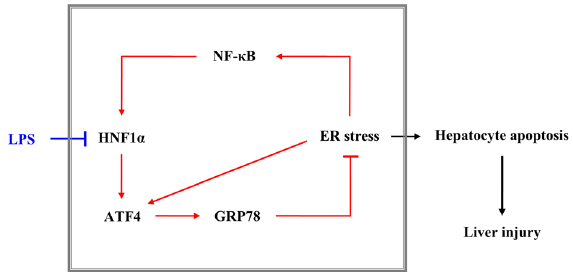
Figure 9. Schematic diagram representing the mechanism of suggested hepatocyte HNF1α–ER stress feedback loop on apoptosis in acute liver injury. Following liver injury, ER stress upregulates the expression of HNF1α by activating NF-κB signaling; the upregulated HNF1α reduces ER stress through positive feedback regulation with ATF4, which results in upregulation of GRP78 expression and reduction of hepatocyte apoptosis and